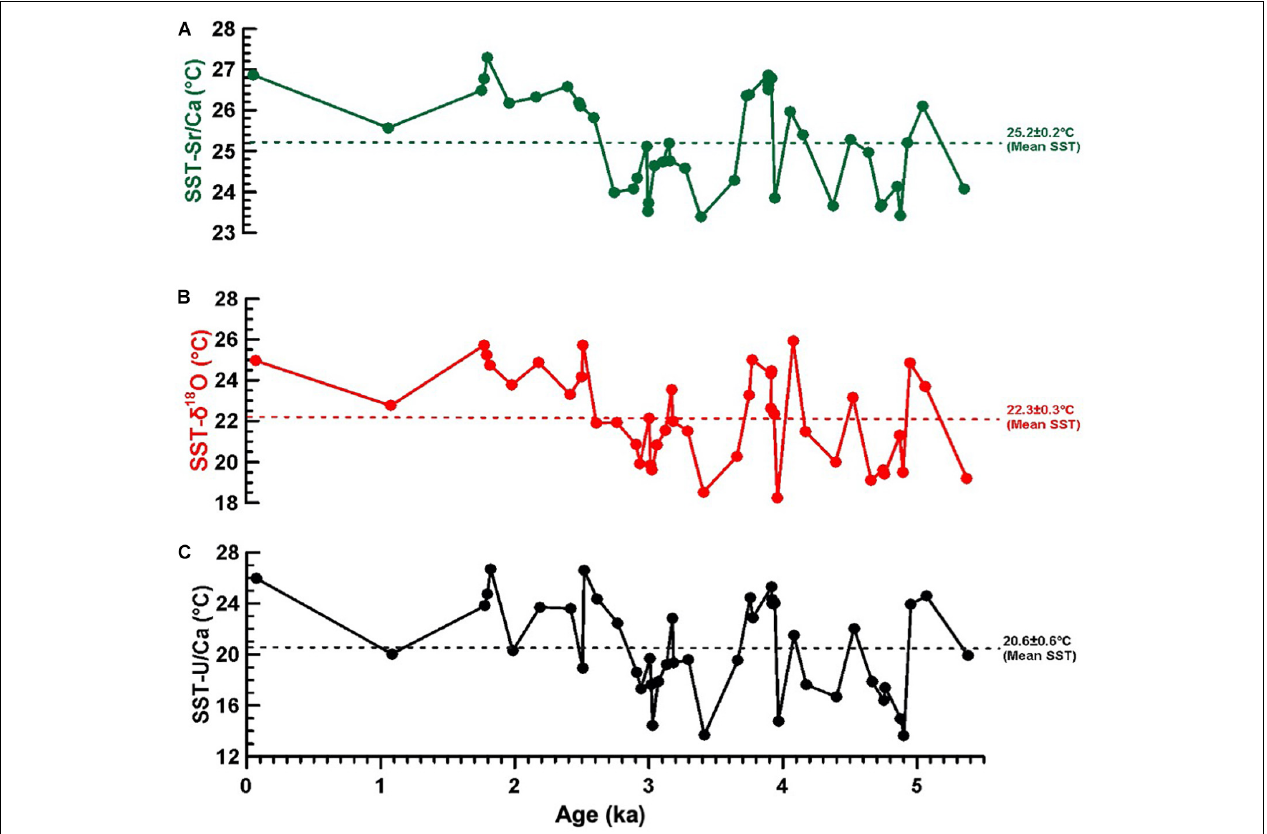
FIGURE 7 | Comparison of SSTs records for Mid to Late Holocene derived from: (A) Sr/Ca ratios; (B) δ 18 O values; and (C) U/Ca ratios. Dashed lines indicate the mean SST estimate for each proxy